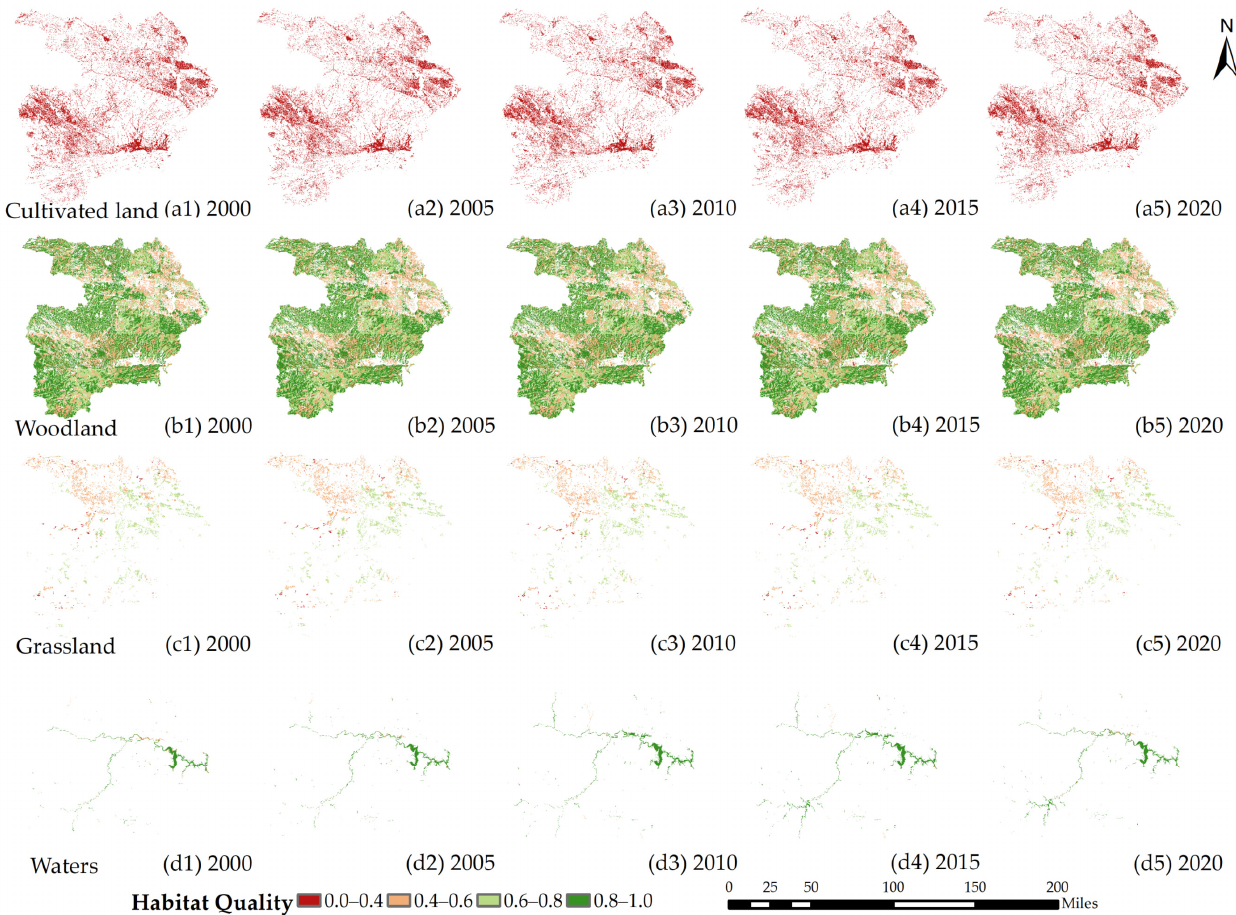
Figure 8. Habitat quality change of different land use types in Shiyan from 2000 to 2020. Cultivated land: ( a1 ) 2000, ( a2 ) 2005, ( a3 ) 2010, ( a4 ) 2015, and ( a5 ) 2020; woodland: ( b1 ) 2000, ( b2 ) 2005, ( b3 ) 2010, ( b4 ) 2015, and ( b5 ) 2020; grassland: ( c1 ) 2000, ( c2 ) 2005, ( c3 ) 2010, ( c4 ) 2015, and ( c5 ) 2020; waters: ( d1 ) 2000, ( d2 ) 2005, ( d3 ) 2010, ( d4 ) 2015, and ( d5 ) 2020.